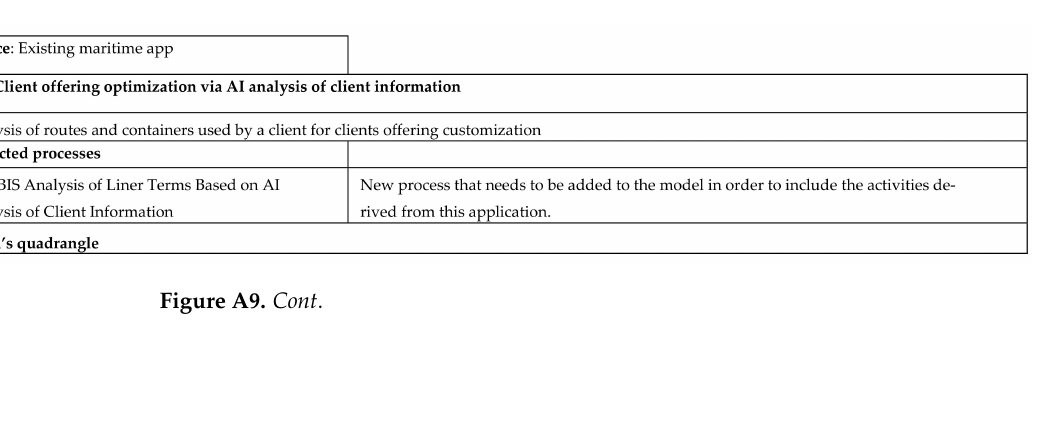
Figure A8. Route optimization via AI analysis of client information data sheet.